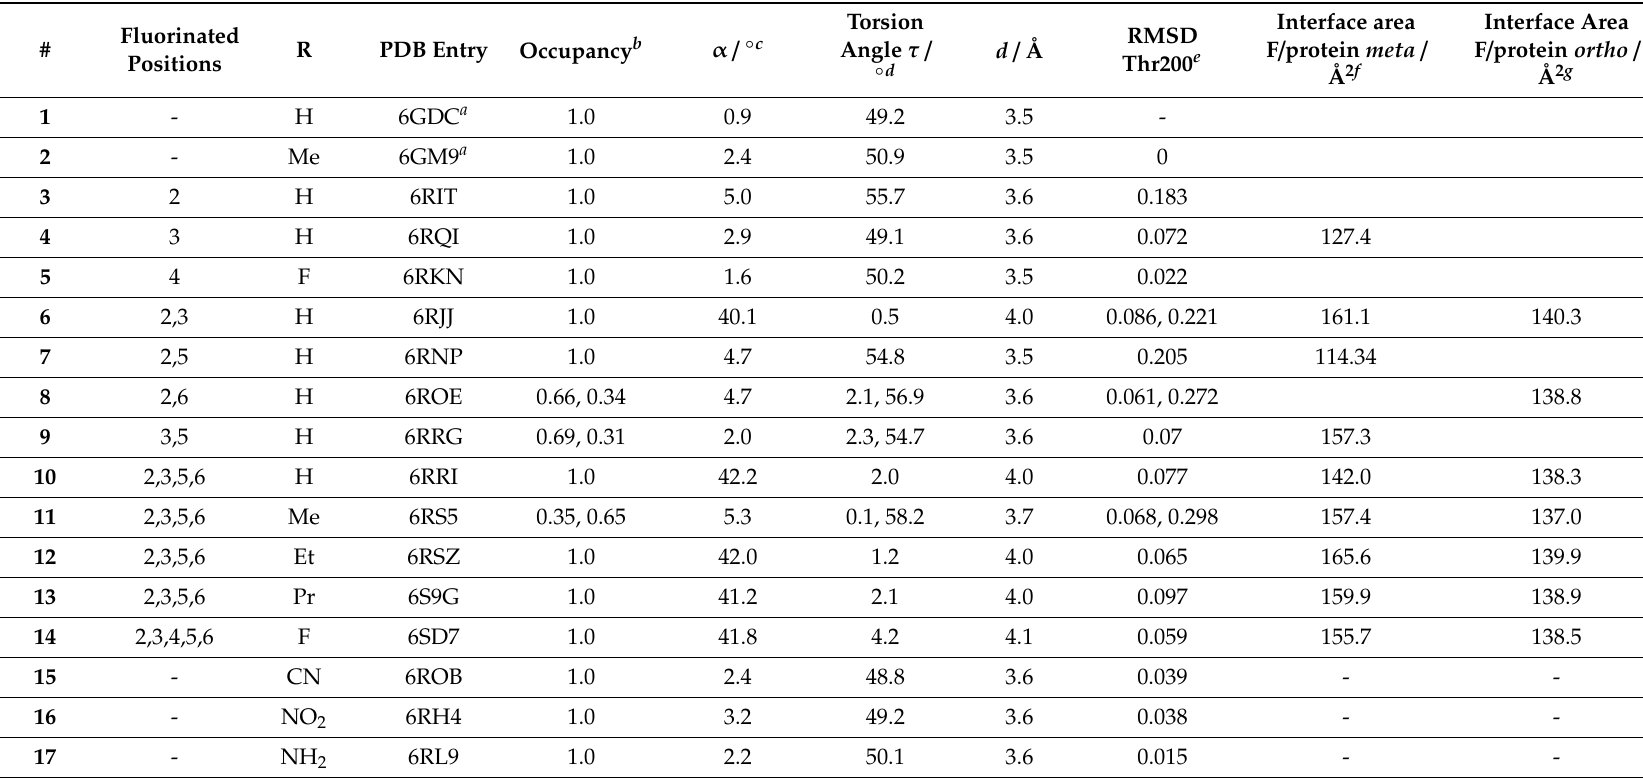
Table 1. Compounds investigated herein with geometric metrics derived from the respective crystallographic models. Derivations of α , d (the absolute value of the → d and the torsion angle are depicted in Figure deviation vector